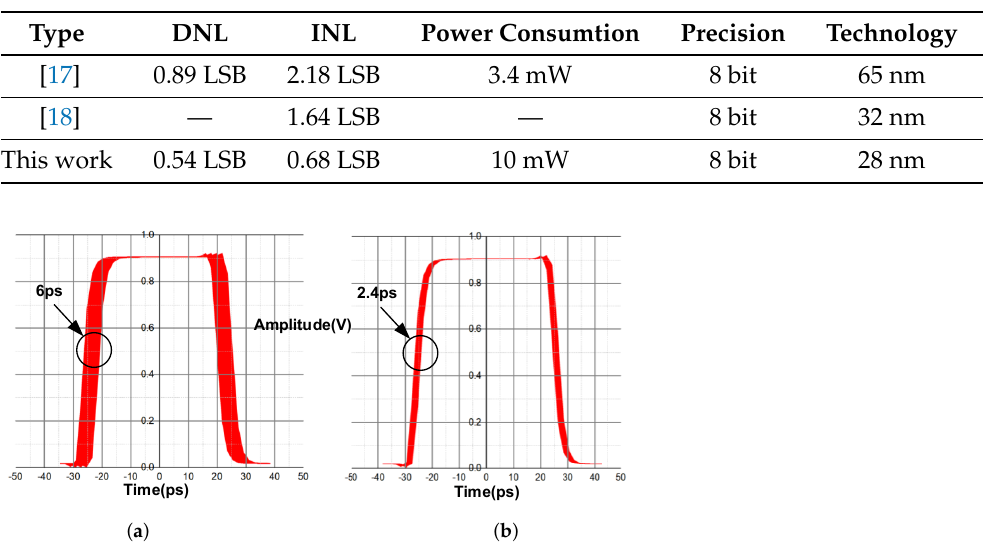
Figure 22. ( a ) PLL output clock when using traditional PI, ( b ) PLL output clock when using im- proved PI.